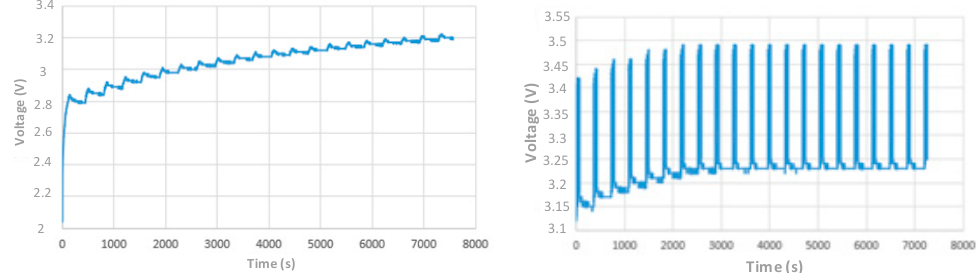
Figure 13. The voltage waveform of initially deeply discharged cell after application of the first sequence of regeneration algorithm ( left ) and the last, sixth sequence ( right ). Table 4. Voltage levels before and after each regeneration sequence of deeply discharged cell. The Voltage on the Cell before the Sequence The Voltage on the Cell after the Sequence